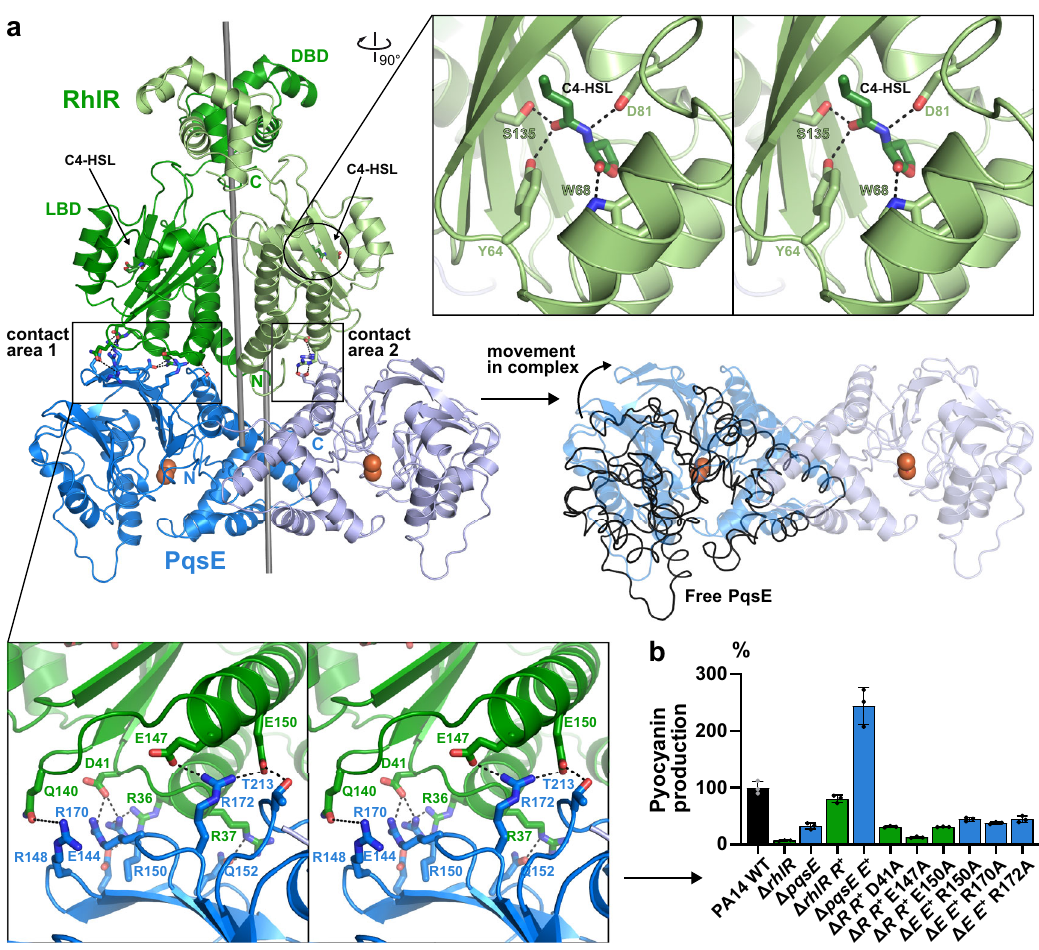
Fig. 3 | Structure of the PqsE/RhlR complex. a Crystal structure of the PqsE/ RhlR:C4-HSL complex. DBD and LBD denote the DNA-and ligand-binding domains of RhlR, the two-fold symmetry axes of RhlR and PqsE are shown as sticks (calcu- latedwithdraw_rotation_axis.pyinPyMOL 73 ).Redspheresrepresenttwoironatoms bound to the active center of PqsE. The magni fi ed area at the top right shows a cross-eyed stereo plot of polar interactions between C4-HSL and RhlR, the mag- ni fi ed area below demonstrates polar interactions between RhlR and PqsE in the